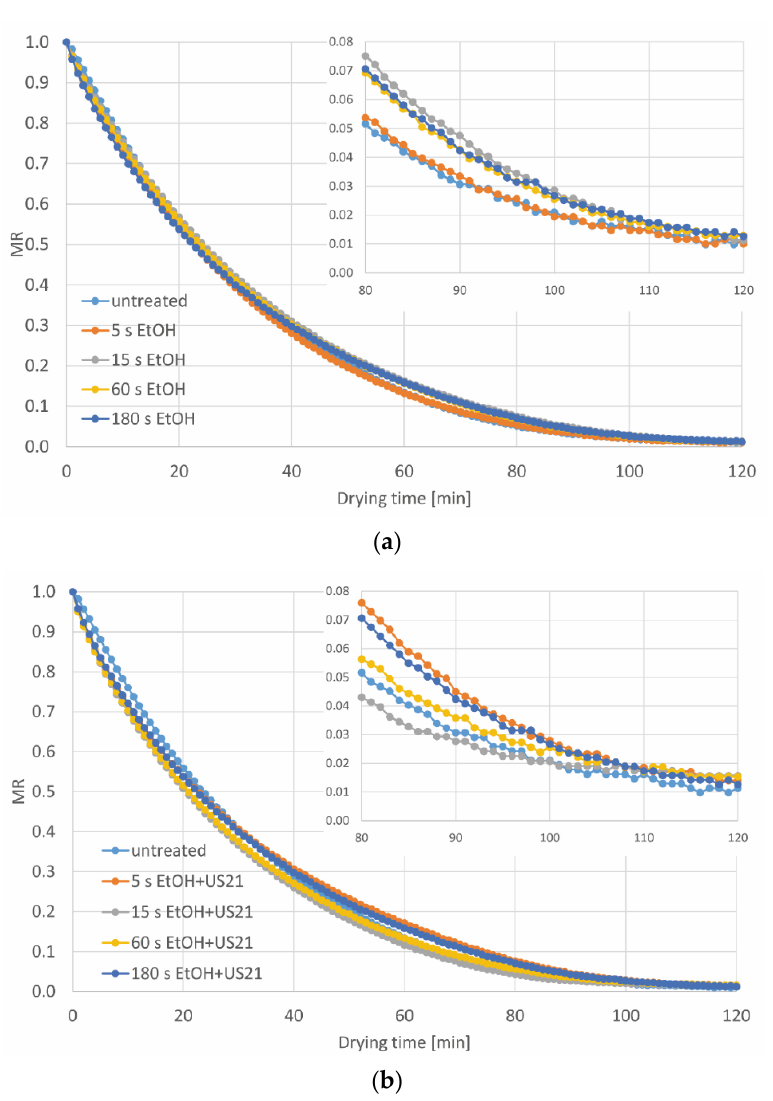
Figure 3. The drying kinetics of carrot tissue pre-treated ( a ) without and ( b ) with ultrasound, a, b, etc.—different letters indicate different homogeneous groups (α = 0.05).